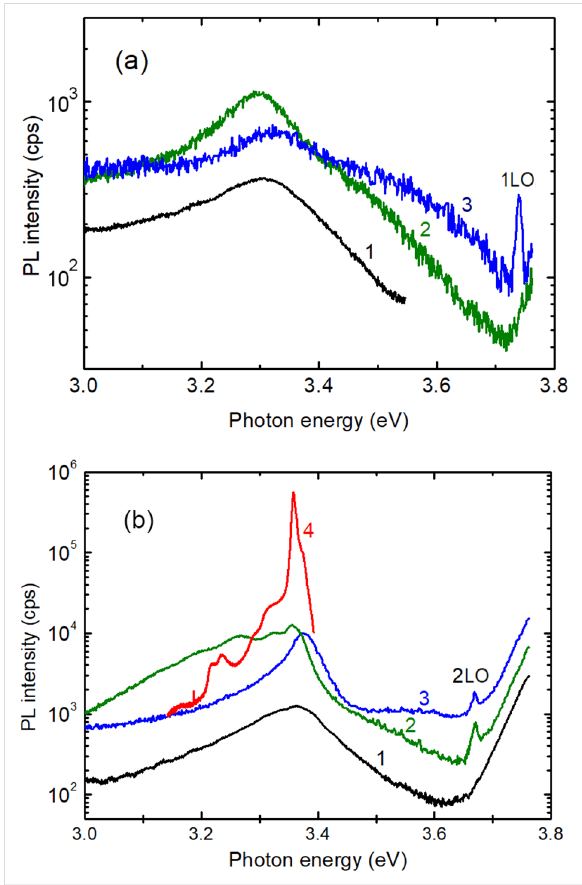
Figure 5: PL spectra of Zn 1 − x Mg x O films deposited by spin coating with x values of 0.00 (1); 0.10 (2); and 0.25 (3), annealed at 400 °C and measured at a) 300 K and b) 20 K. For comparison, the spectrum of a bulk ZnO single crystal is shown by curve